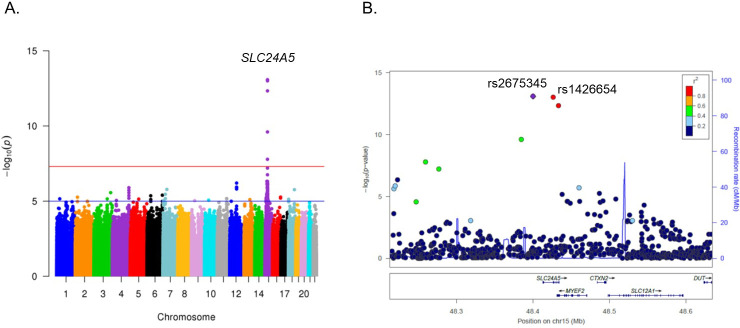
GWAS results: Manhattan plot showing a strong association between SLC24A5 SNPs on chromosome 15 and M-Index (A) and LocusZoom plot of SLC24A5 region (B).